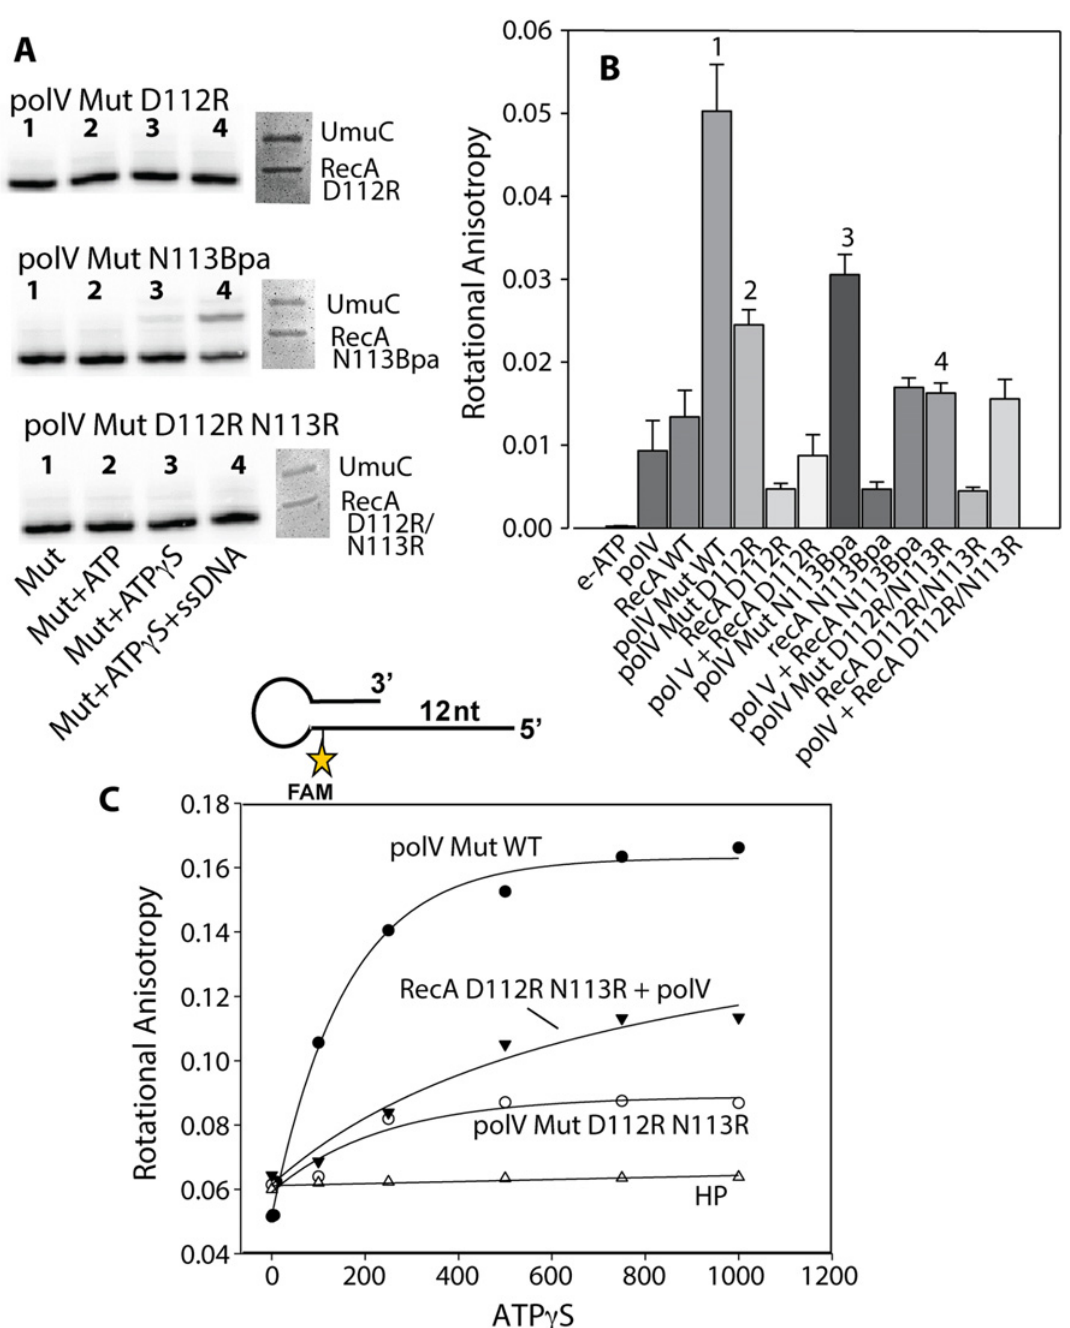
Fig 9. Defining the step in the pol V activation pathway that is affected by RecA D112R N113R. Active DNA polymerase V-Mut was generated with multiple RecA variants as described in Methods, and subjected to several experimental procedures. (A) The activity of pol V Mut D112R, pol V Mut N113RBpa and pol V Mut D112R N113R (400 nM each) was detected on 5'- 32 P-labeled 12 nt oh HP (100 nM) in the presence or absence of ATP/ATP γ S and dNTPs. ssDNA and ATP γ S were added to the reactions to detect free RecA and determine whether pol V Mut could be transactivated (left panels). Pol V Mut variants were resolved by SDS-PAGE and protein components were visualized via Imperial staining (right panels). (B) Binding of pol V Mut and pol + RecA mixtures (400 nM each) to ε -ATP (500 μ M) was measured using rotational anisotropy. The error bars correspond to 1 SEM. Numbers above four of the bars are described in the text. (C) Binding of pol V Mut WT (400 nM), pol V + RecA D112R N113R (400 nM each) and pol V Mut D112R N113R (400 nM) to fluorescein-labeled 12 nt oh HP (50 nM) was measured as a function of ATP γ S. DNA binding was observed as a change in rotational anisotropy. The rotational anisotropy of HP alone is included in the